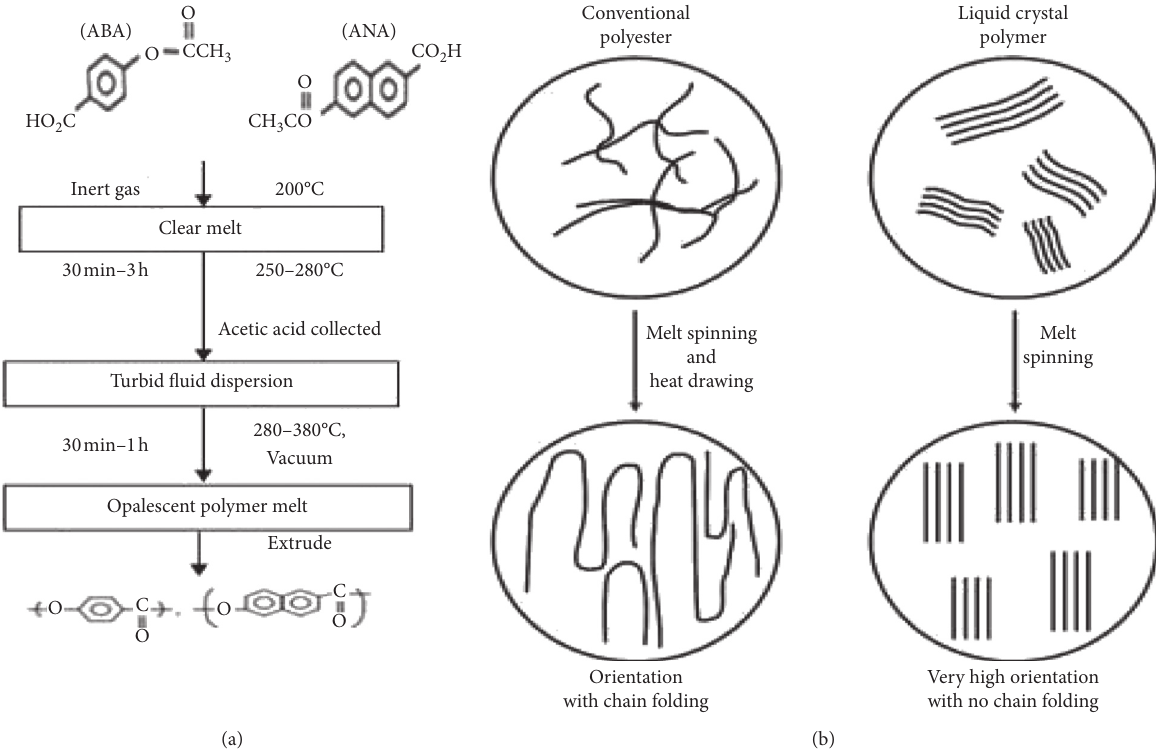
Figure 2: (a) Polymerization process for HBA/HNA copolymer; (b) molecular orientation in conventional and liquid crystal polymer